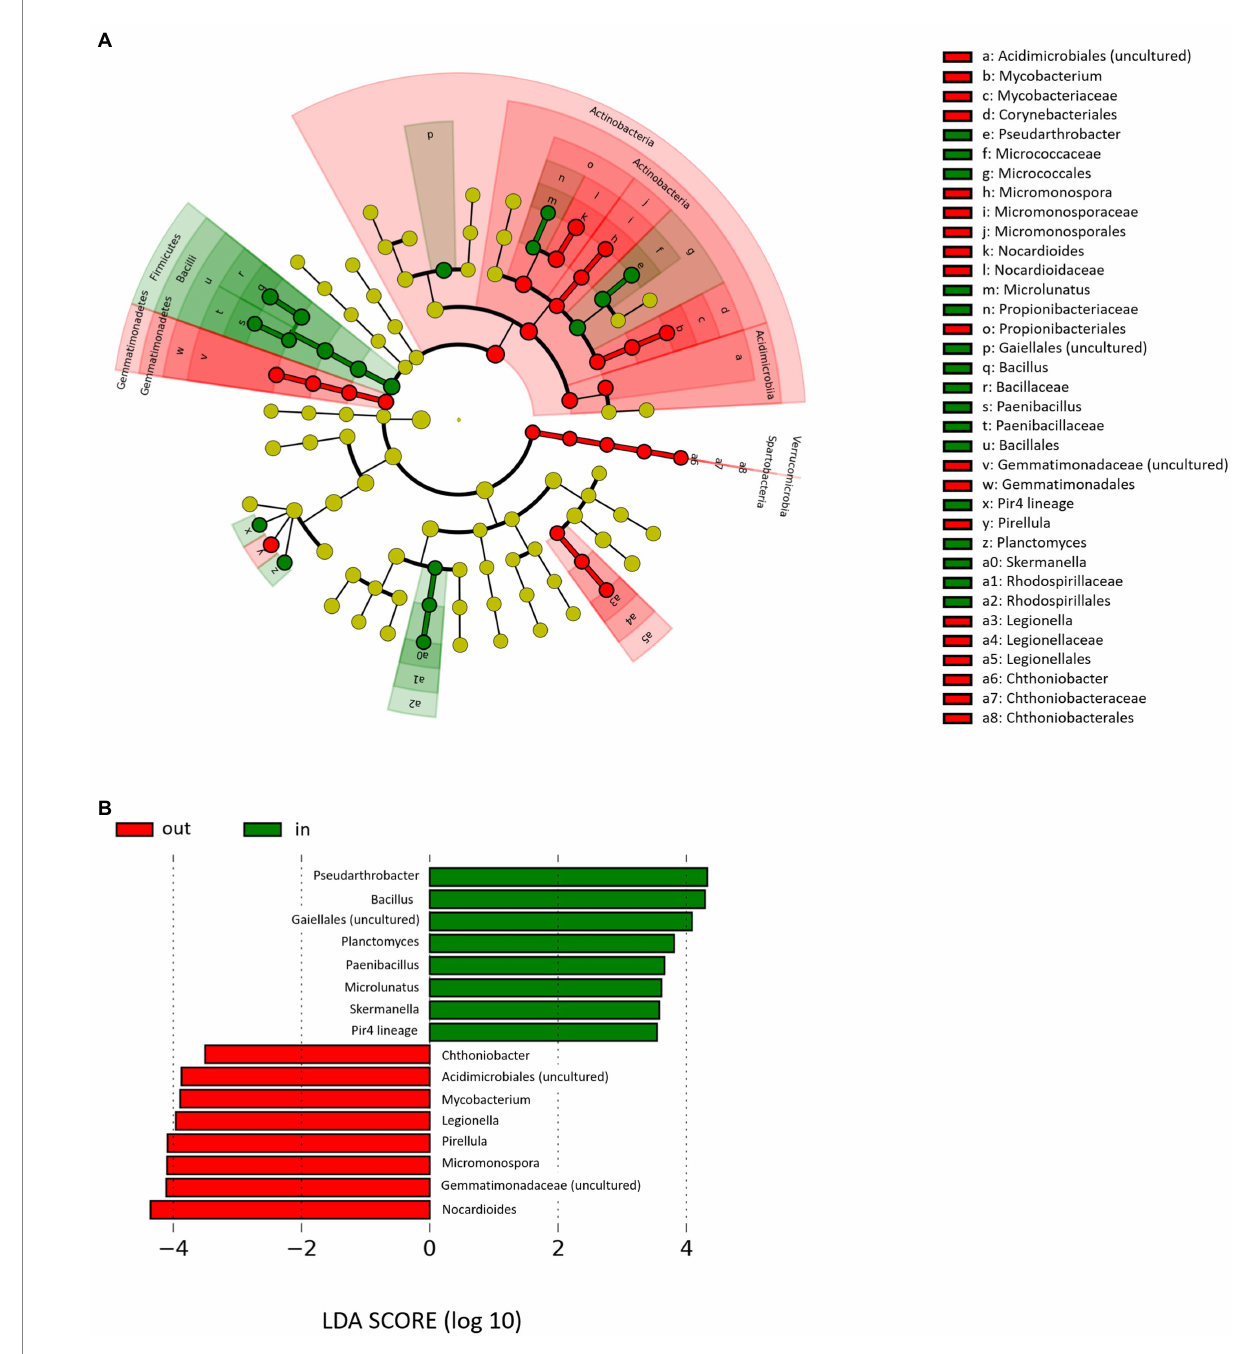
FIGURE 4 Rhizospheric microbiome signatures of PDO production sites. (A) Cladogram of microbial taxa differentially represented between farms located inside (Finale Emilia and Medolla, green) and outside (Bondeno, red) the PDO area at phylum to genus level. Only genera whose relative abundance was higher than 0.5% in at least 33% of the rhizospheric samples are represented. The diameter of each circle is proportional to the genera relative abundance within the entire rhizospheric cohort. (B) Linear discriminant analysis (LDA) scores of discriminating genera between the abovementioned groups (the logarithmic threshold for discriminative features was set to 2.0). Plots were obtained by LDA effect size (LEfSe)